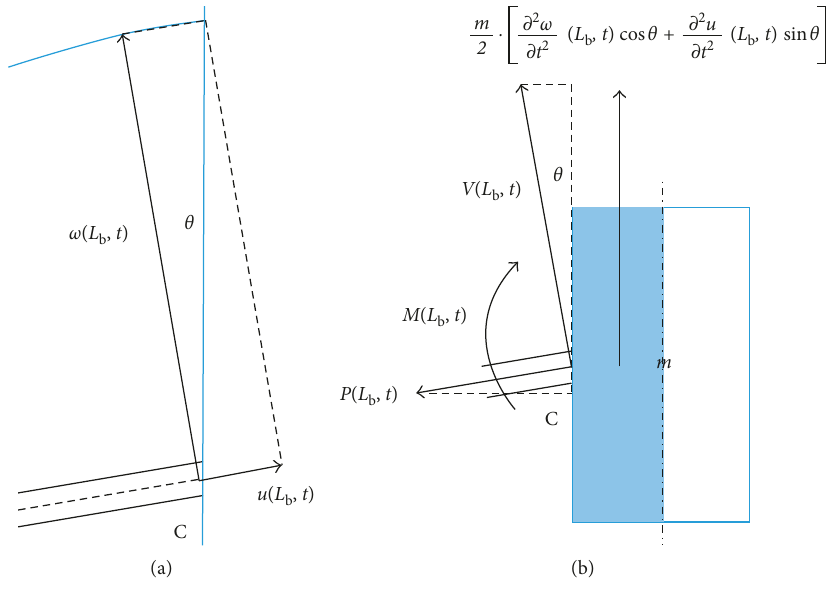
Figure 3: Continuity conditions.